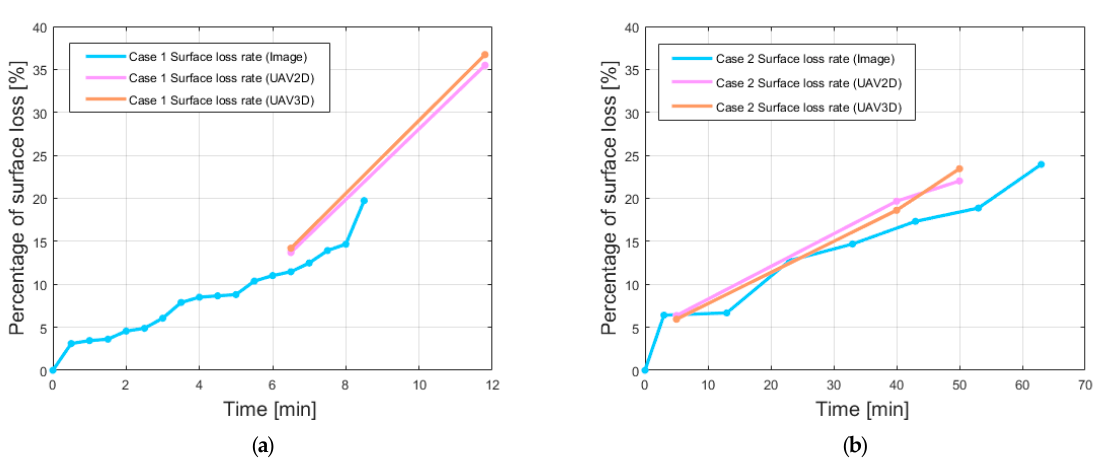
Figure 13. Surface loss rate using 3D point cloud modeling ( a ) sand levee, and ( b ) reinforced novel materials levee at 40 min.